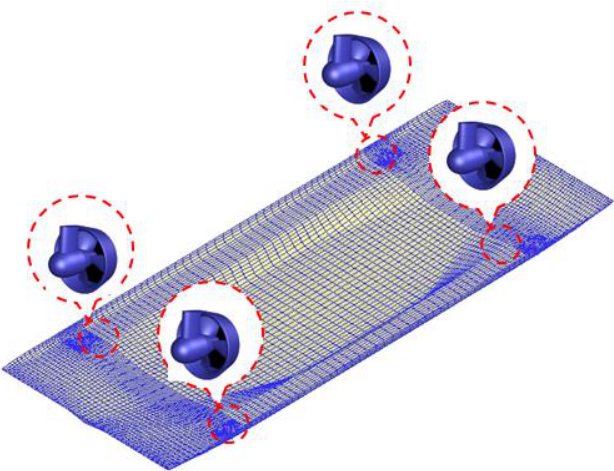
Figure 3. Sketch of thruster positions.